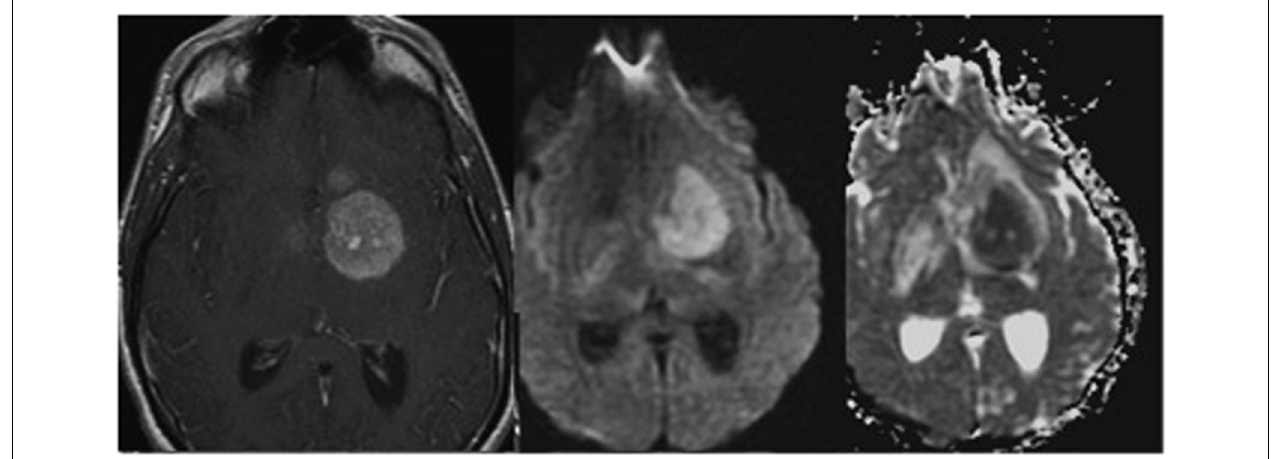
FIGURE 1 |T1-weighted image of a glioma following contrast enhancement using a gadolinium-based contrast agent (left). Diffusion weighted images DWI ( middle ), and apparent diffusion coefficient map ADC ( right ) of the same tumor patient. Adapted fromYoung (2007), reproduced with permission.